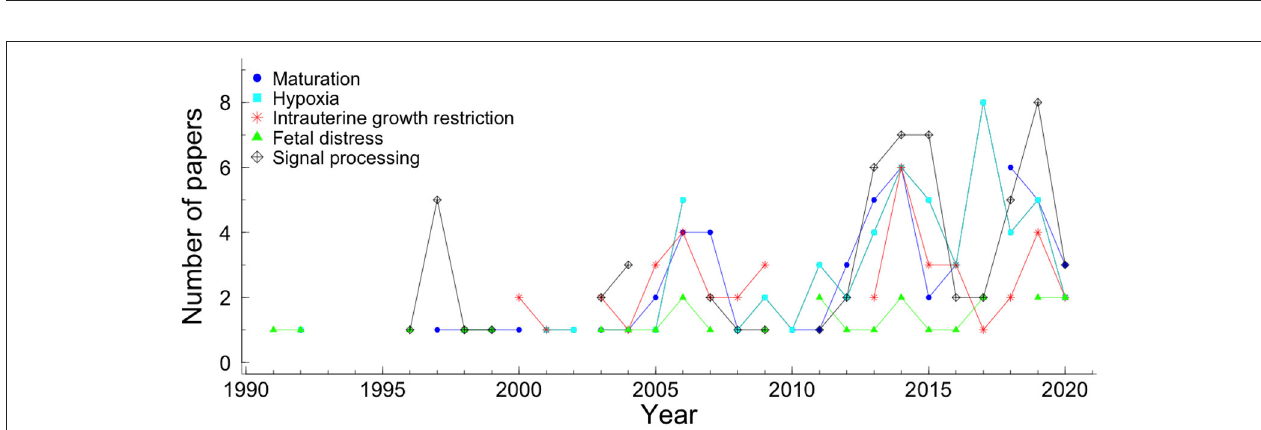
FIGURE 6 | The wavelet families most used in fHR analysis, by year. The colors and symbols represent the wavelet families. The black circle, blue triangle, purple diamond plus, green square, and star red represented Daubechies family, spline family, symlet family, coiflet family, and other families, respectively.